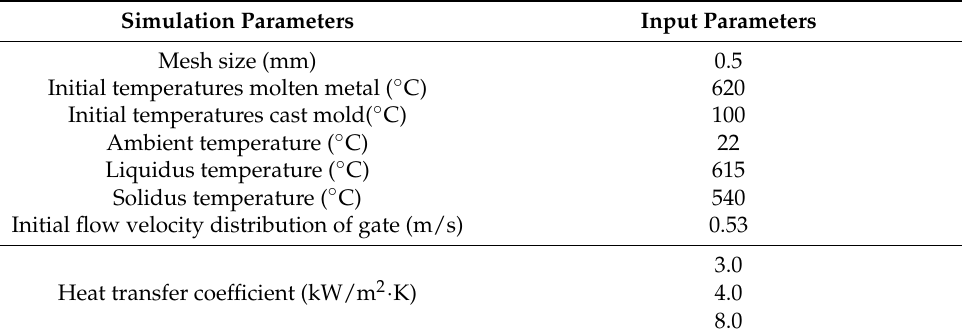
Table 2. Casting simulation input data of Al–7%Si–0.3%Mg alloy.